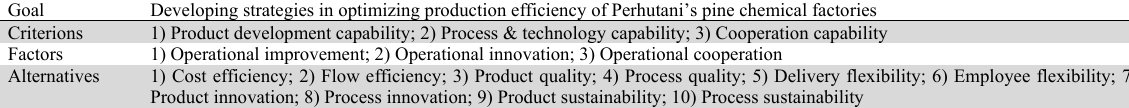
Hierarchical Structures in AHP Questionnaire Pairwise Comparison Goal Developing strategies in optimizing production efficiency of Perhutani’s pine chemical factories